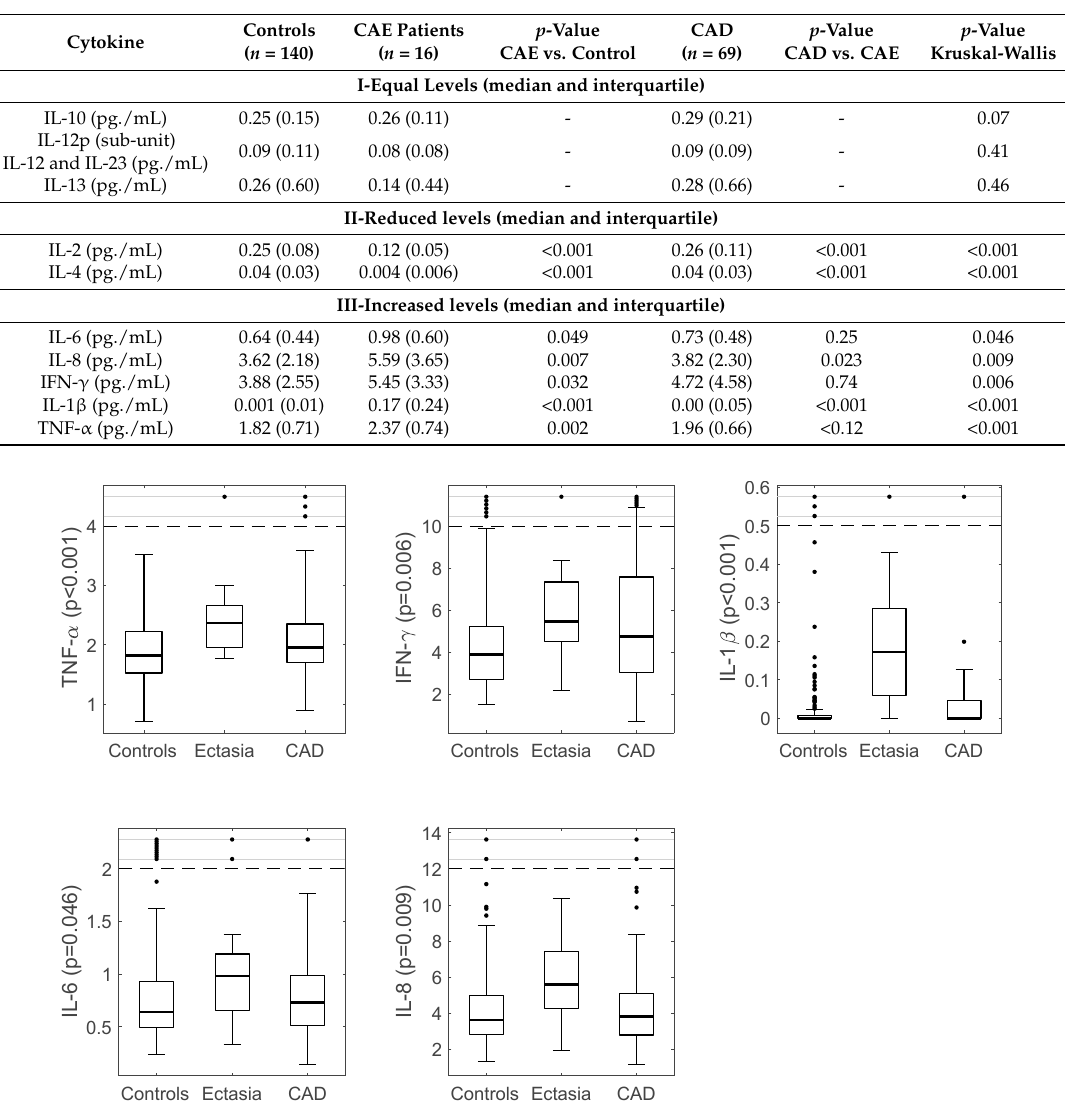
Table 2. Immuno-inflammatory response and related cytokines levels in the coronary artery ectasia (CAE) group versus control group and coronary artery disease (CAD) patients. Data is presented as median (interquartile range) and p -values is derived from Kruskal–Wallis H -tests, using Dunn’s test with Bonferroni correction for post-hoc tests.